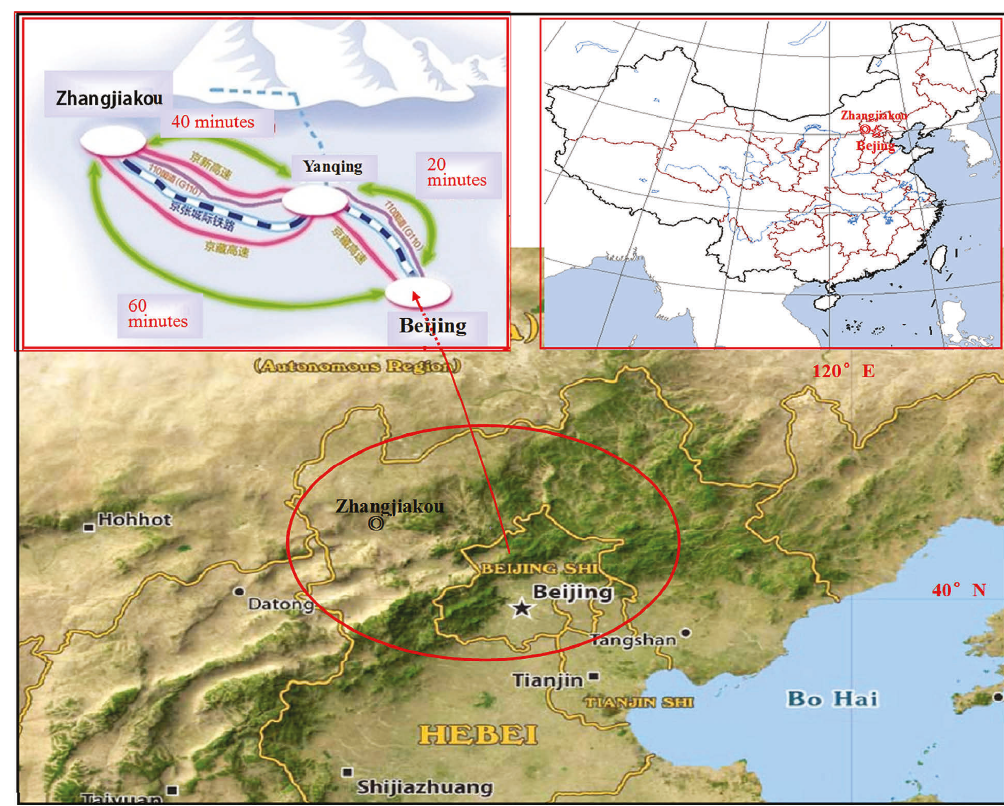
Figure 1: Beijing Winter Olympic Games competition venue in 2022. Table 2: List of studies on the relationship between air pollutions and boundary layers in recent